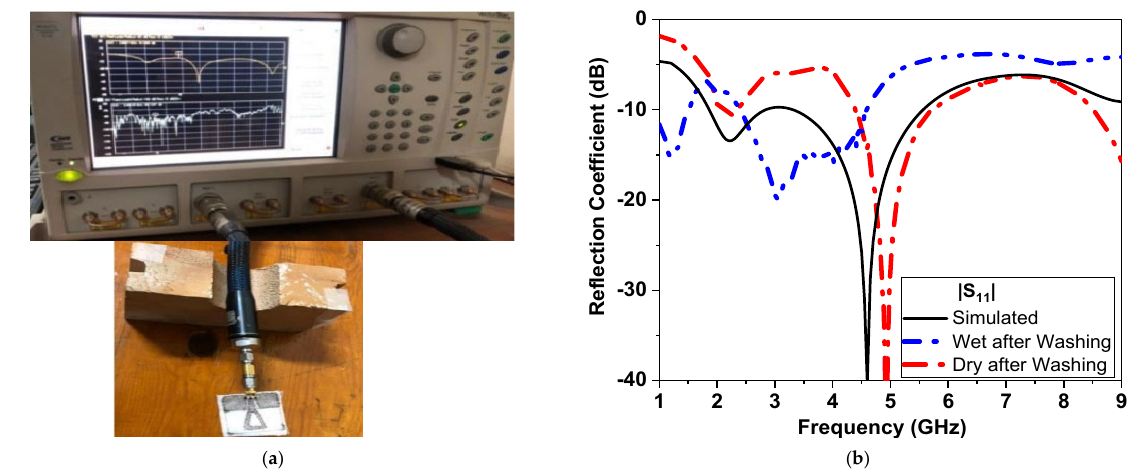
Figure 19. ( a ) Reflection measurement setup for fabricated CPMS sensor connected to vector network analyzer (VNA) and ( b ) simulation and measurement of reflection coefficient in dB versus frequency at different washing stages.